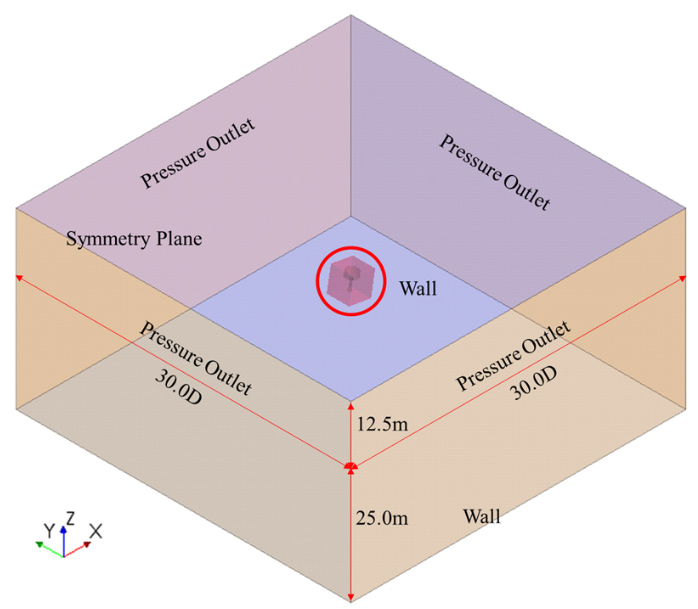
Figure 8. Computational domain and boundary conditions of the free decay test of lightweight light buoys using CFD.